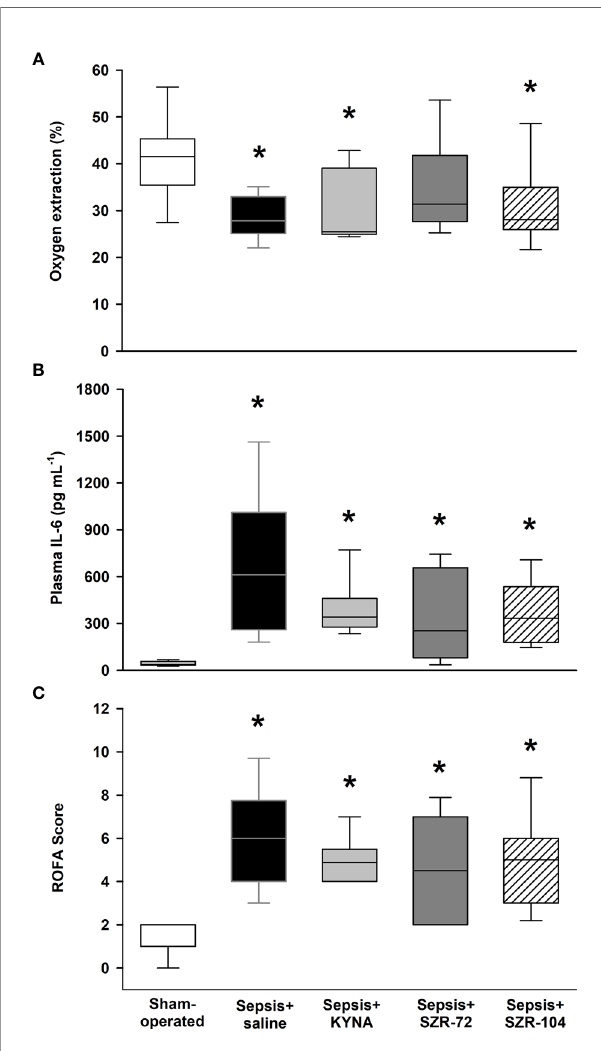
FIGURE 2 | Oxygen extraction ratio (OER, A ), plasma IL-6 levels (B) and rat- speci fi c organ failure assessment (ROFA) score (C) in the sham-operated group and in the different sepsis groups treated with saline, KYNA, SZR-72 and SZR-104. The plots demonstrate the median (horizontal line in the box) and the 25 th (lower whisker) and 75 th (upper whisker) percentiles. Kruskal – Wallis test and Dunn ’ s post-hoc test; * P < 0.05 vs . sham-operated group.